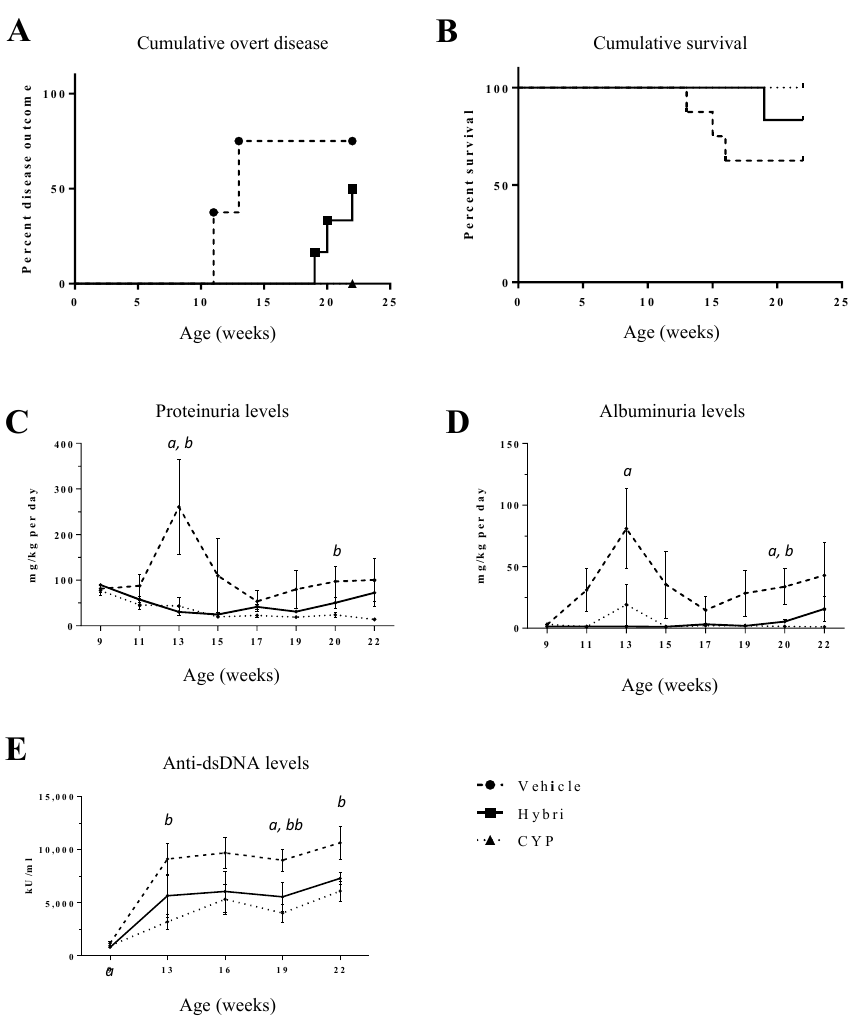
Figure 5. Hybri administration delayed the onset of overt disease, improved the survival curve, and ameliorated functional renal parameters in the MRL/lpr mouse model throughout the study. ( A ) Cumulative overt disease for the MRL/lpr model until the endpoint of the study at 22 weeks of mice age. Disease outcome was considered when proteinuria levels exceeded 3 mg per day. ( B ) Kaplan–Meier survival curve for the MRL/lpr model. Log Rank Mantel–Cox test revealed non-significant differences between groups neither for cumulative overt disease nor cumulative survival. Proteinuria ( C ) and albuminuria ( D ) values throughout the study are expressed in mg normalized per body weight per day. Serum anti-dsDNA ( E ) levels throughout the study are expressed in KU/mL. Vehicle group: n = 8; Hybri group: n = 6; CYP group: n = 6. Data are expressed as mean values ± S.E.M. Hybri vs. Vehicle: a = p < 0.05, aa = p < 0.01; CYP vs. Vehicle: b = p < 0.05, bb = p < 0.01.